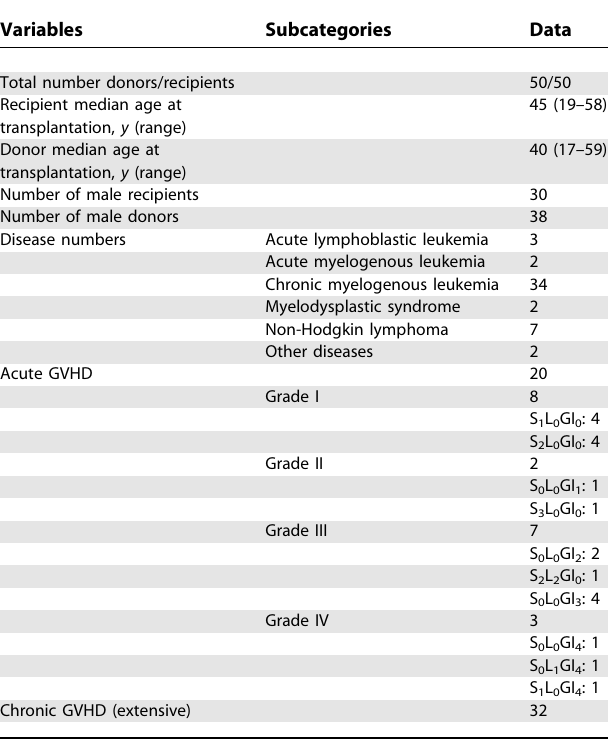
Table 1. Donor–Recipient Characteristics